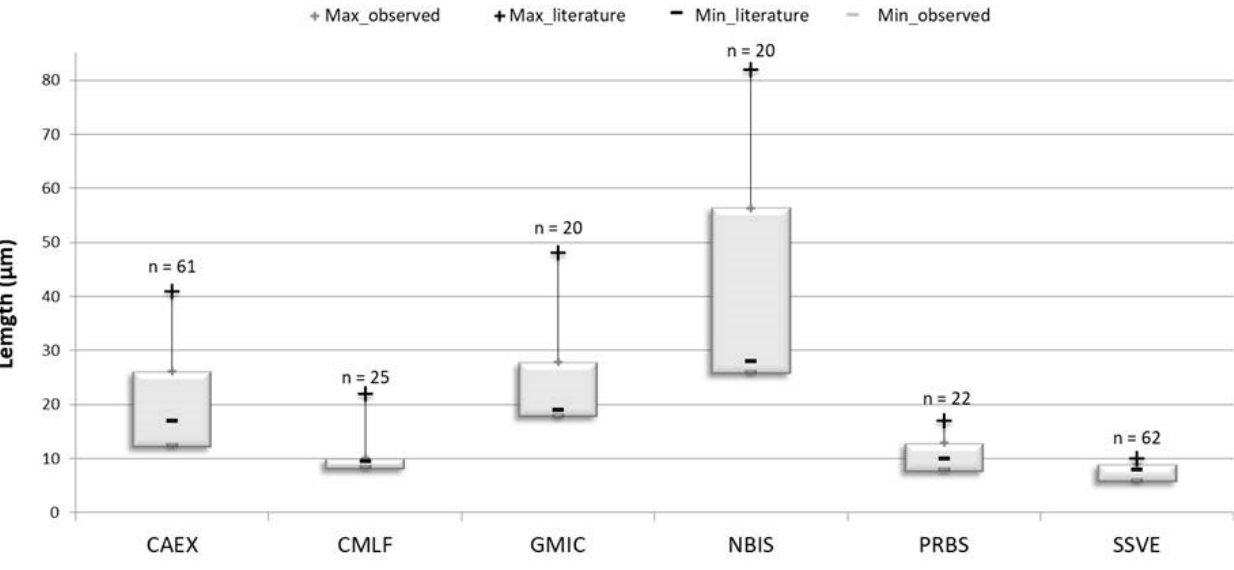
Figure 3. Mean length values for six diatomic species detected in the study area, and comparison with the length ranges reported in the literature. The bold dash represents the mean value of the minimum lengths of the species reported by the author of its description. The gray dash indicates the mean value of the minimum lengths of the species measured in the present study.